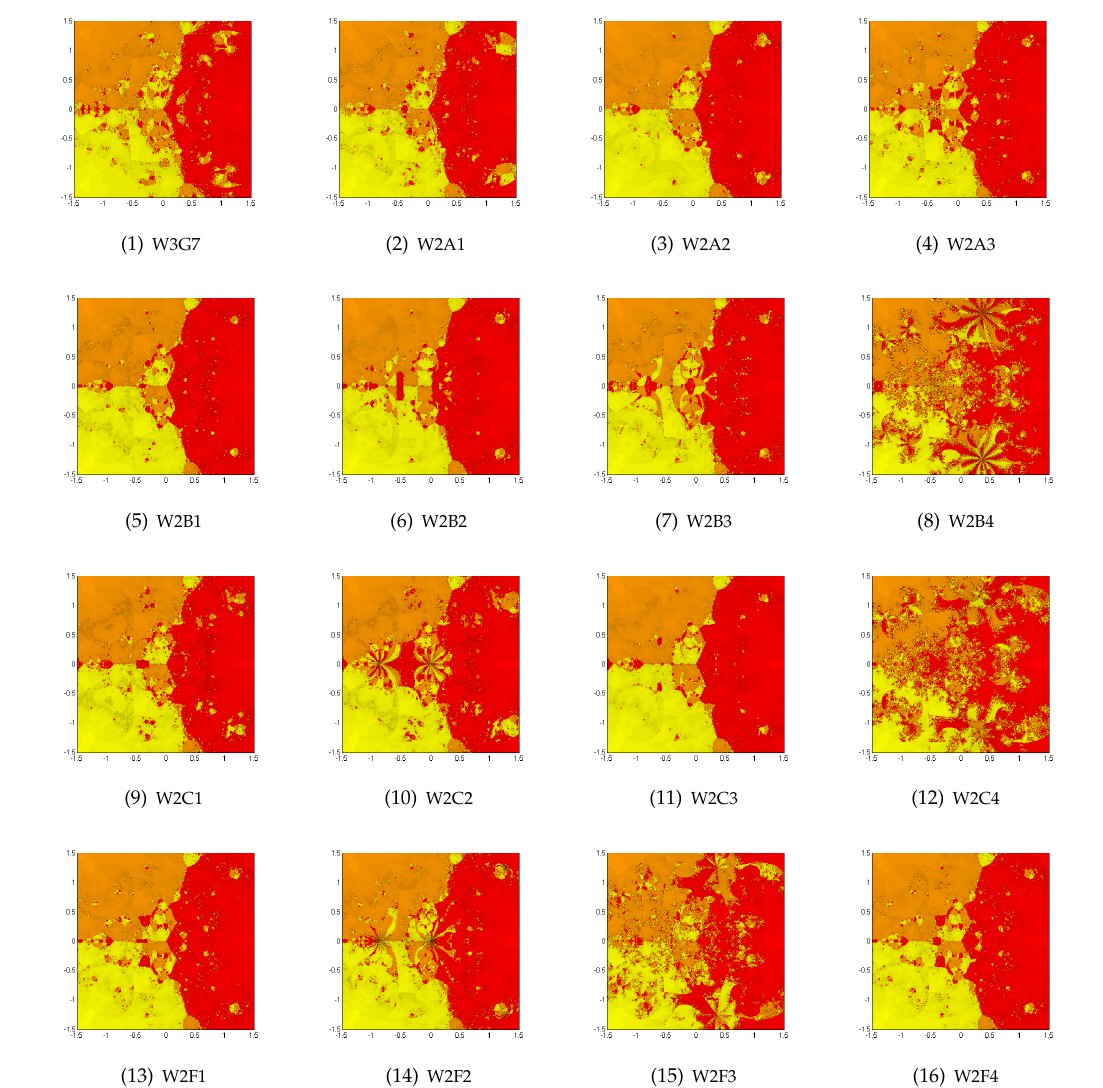
Figure 3. The top row for W3G7 ( left ), W2A1 ( center left ), W2A2 ( center right ) and W2A3 ( right ). The second row for W2B1 ( left ), W2B2 ( center left ), W2B3 ( center right ) and W2B4 ( right ). The third row for W2C1 ( left ), W2C2 ( center left ), W2C3 ( center right ) and W2C4 ( right ). The bottom row for W2F1 ( left ), W2F2 ( center left ), W2F3 ( center right ), and W2F4 ( right ), for the roots of the polynomial equation ( 3 z 3 + 4 z 2 − 10 ) 3